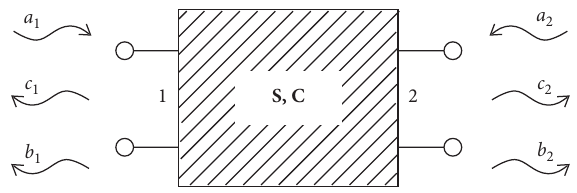
Figure 1: A two-port network associated with the